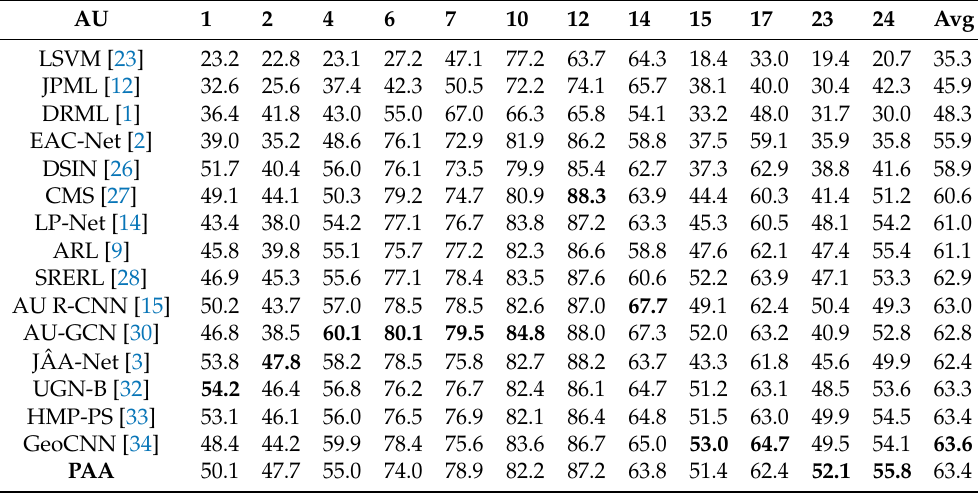
Table 1. F1-frame results on Binghamton-Pittsburgh 4D (BP4D) [18]. The results of LSVM [23] and JPML [12] are from [1], and those of other previous methods are reported in their original papers. The best results of each AU, as well as the average across methods, are shown in bold. Our PAA method performs better than most of the previous